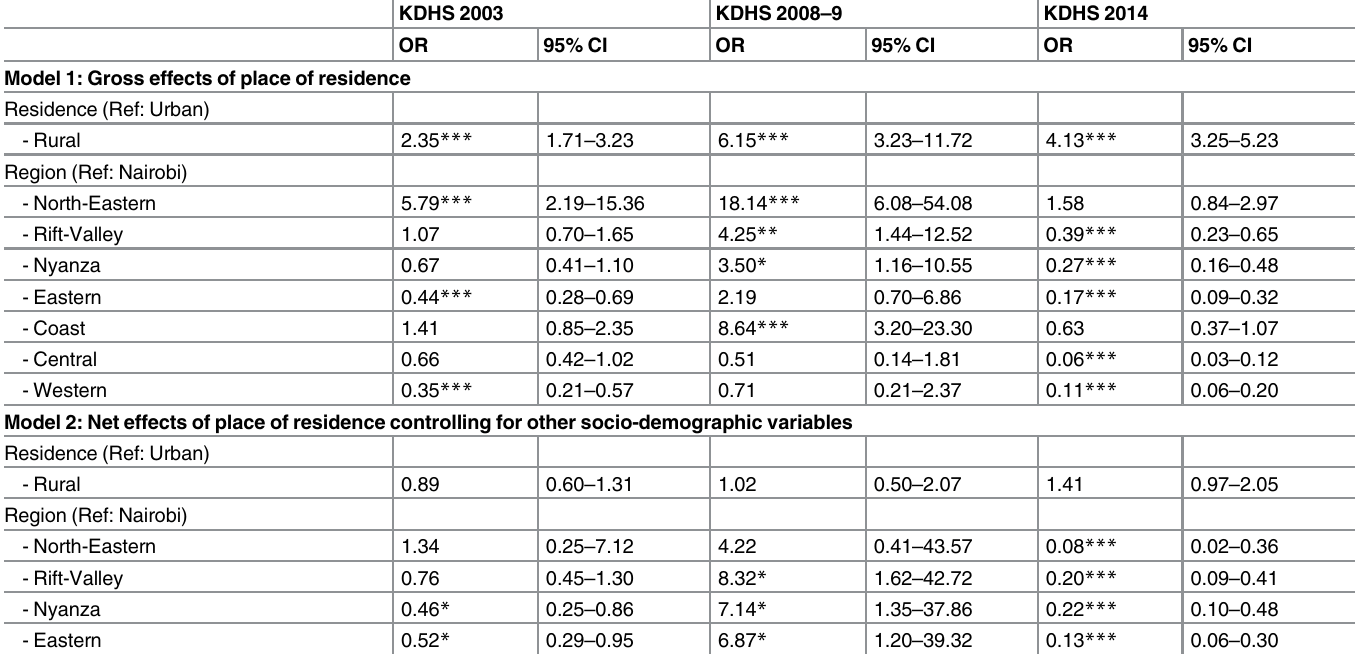
Table 6. Correlates of disposal of child's stool in a